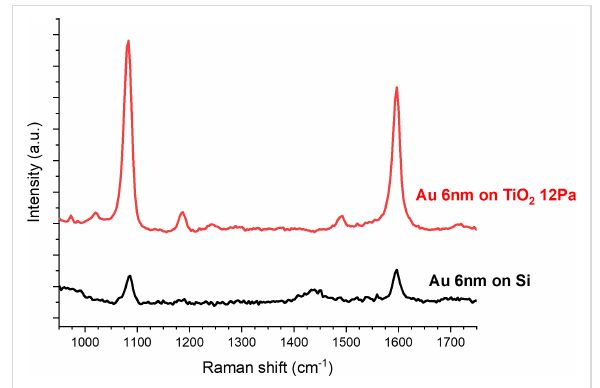
Figure 6: SERS enhancement measured for MBA of the same equiva- lent thickness of evaporated Au deposited on top of a bare Si(100) substrate (black line) and a nanostructured TiO 2 film (red line).